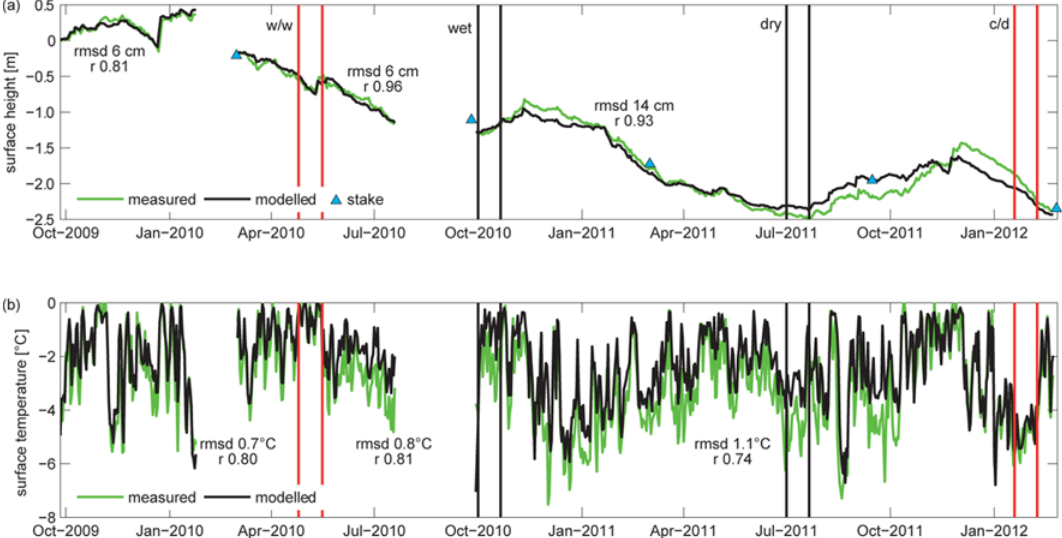
Fig. 4. (a) Comparison of measured and modeled surface height showing daily model performance metrics for each of the three periods, and comparison againsta nearby mass balance stake. Vertical lines indicate the subsampled periods chosen to represent “typical” wet and dry conditions and warm/wet (w/w) and clear/dry (c/d) extremes. (b) Comparison of measured and modeled daily mean surface